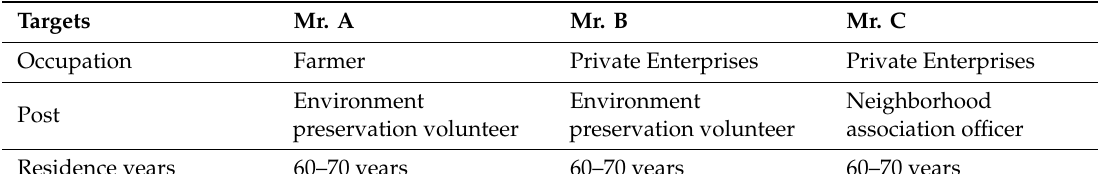
Table 2. Results of the interview